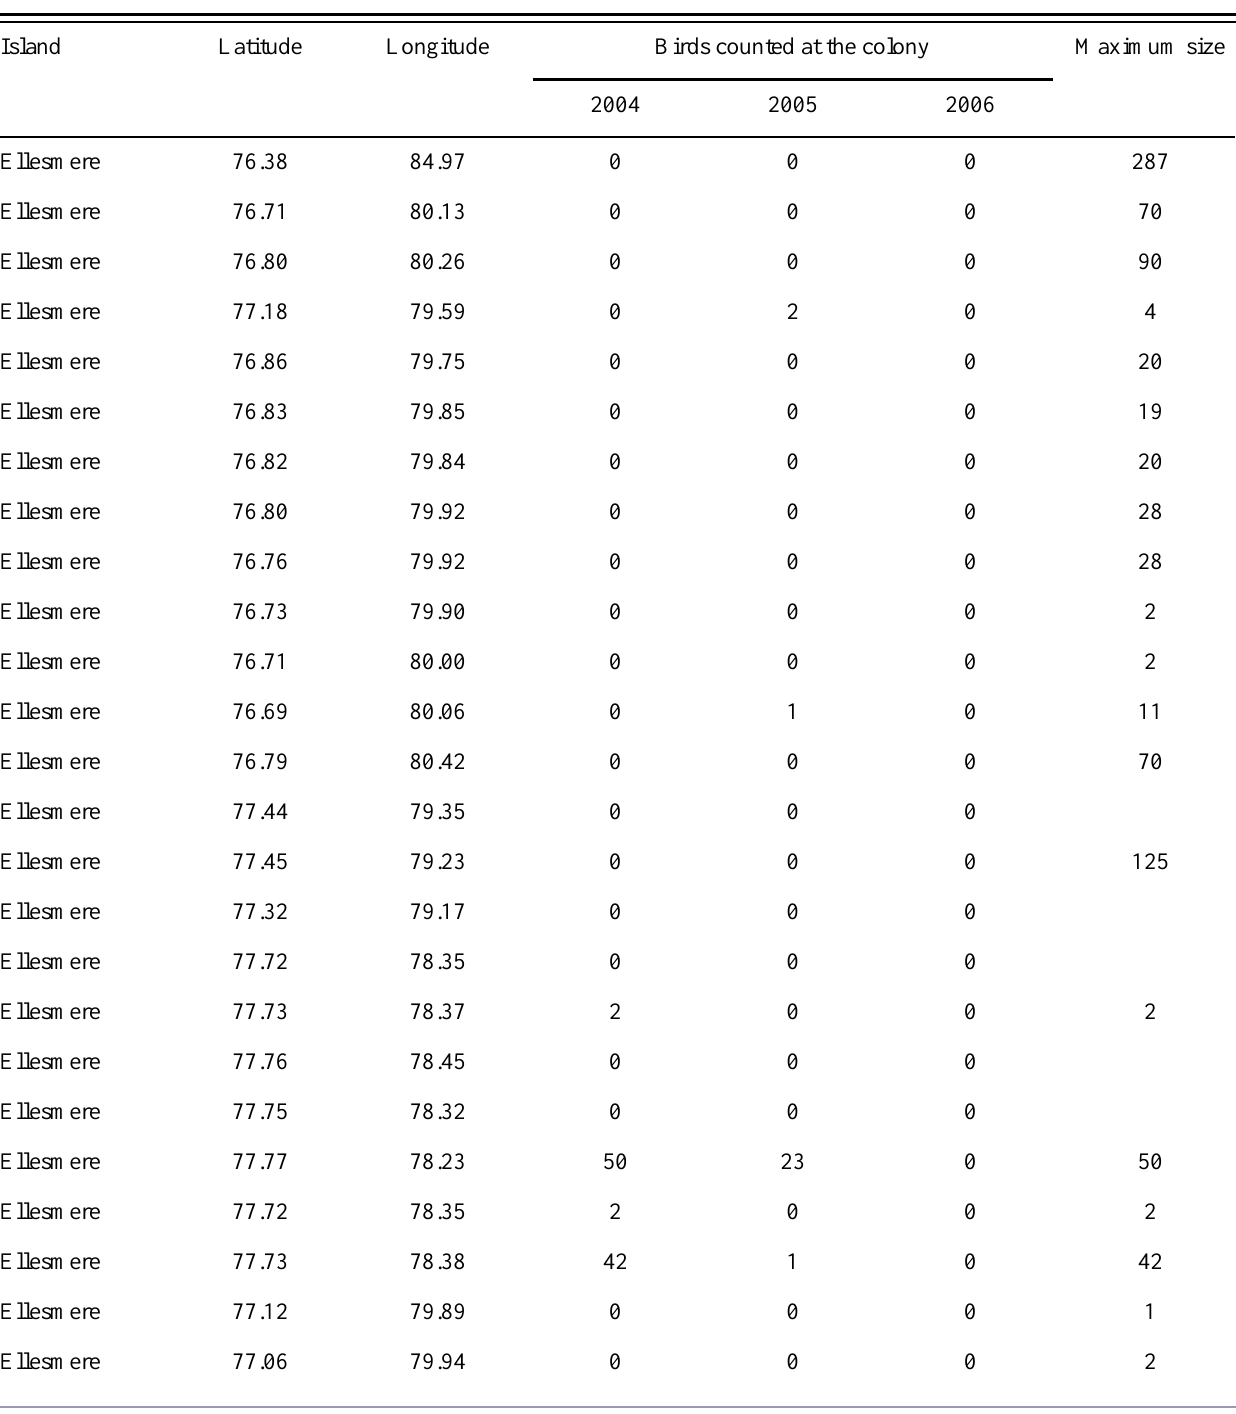
Table 2. Ivory Gull colony locations, counts in 2004–2006, and maximum recorded colony sizes from surveys or